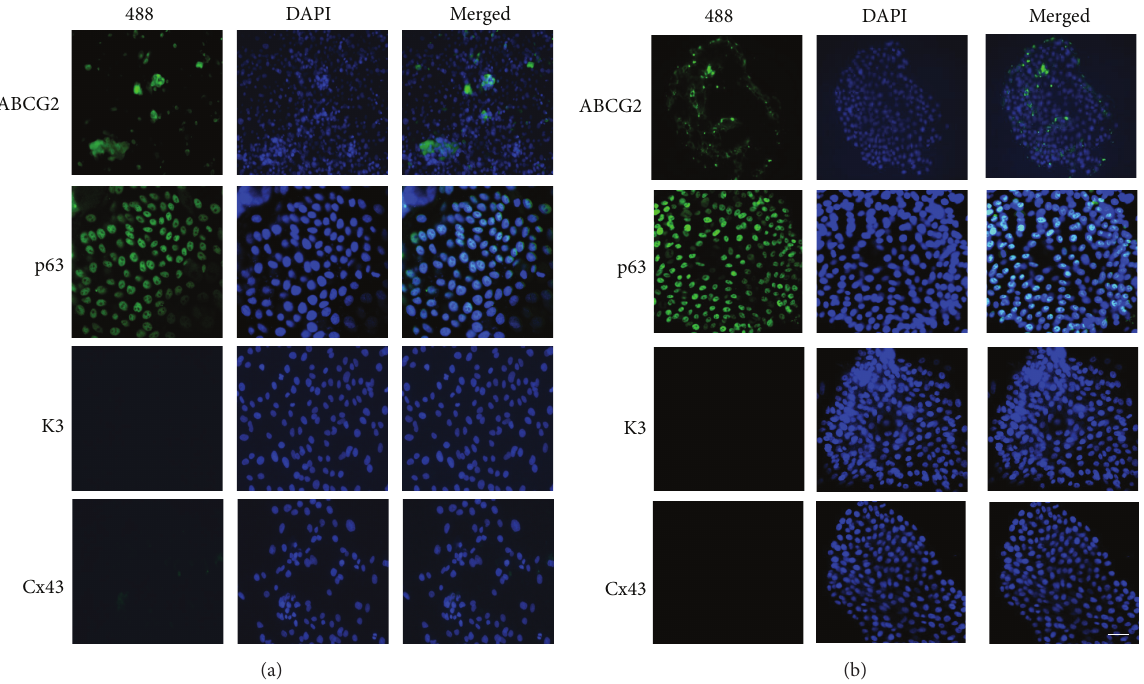
Figure 4: Expression of epithelial stem cell makers and differentiation markers in human limbal epithelial cells. The human limbal epithelial cells were strongly stained with ABCG2 and p63 (green) in SR and FAD media. The cells maintained in SR and FAD media showed weak staining for connexin 43 (Cx43) and cytokeratin 3 (K3). (a) SR medium and (b) FAD medium. Original magnification: (a) × 10; (b) × 10 (scale bars: 100 𝜇 m). The studies were carried out in triplicate, and representative figures are shown